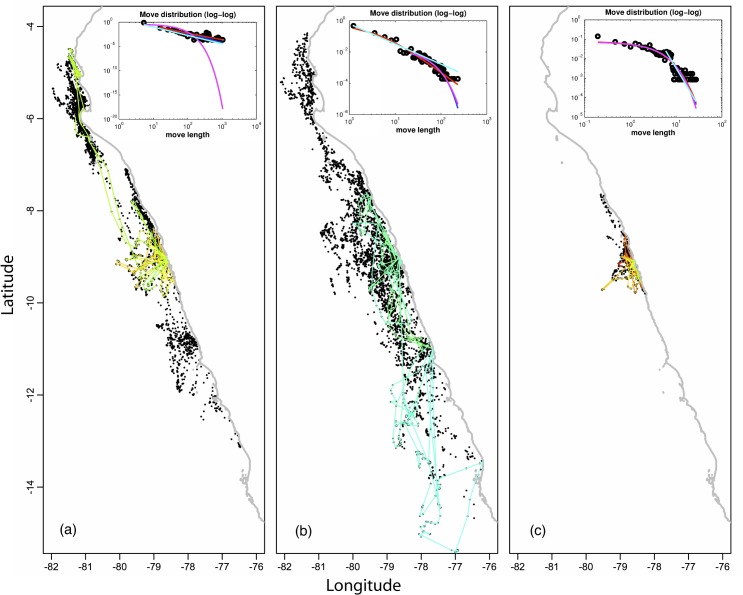
Fishing trips from anchovy purse seiners a (left panel), b (central panel) and c (right panel).Black dots represent the global set of positions for fishing trips deployed during one year. A sample of 25 fishing trips is represented with colored lines. The inset gives the log-log plot of the total move length distribution together with the fits of the four candidate models (Generalized Pareto in dark blue, Bounded Generalized Pareto in red, exponential in pink and power in light blue).